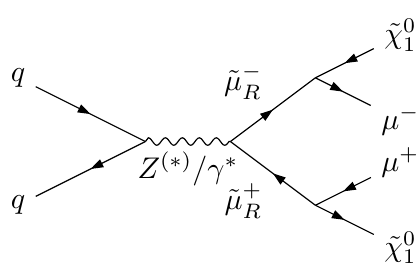
Figure 1 . Representative Feynman diagram for the process considered, featuring the production of a muon pair and a neutralino pair in a proton-proton